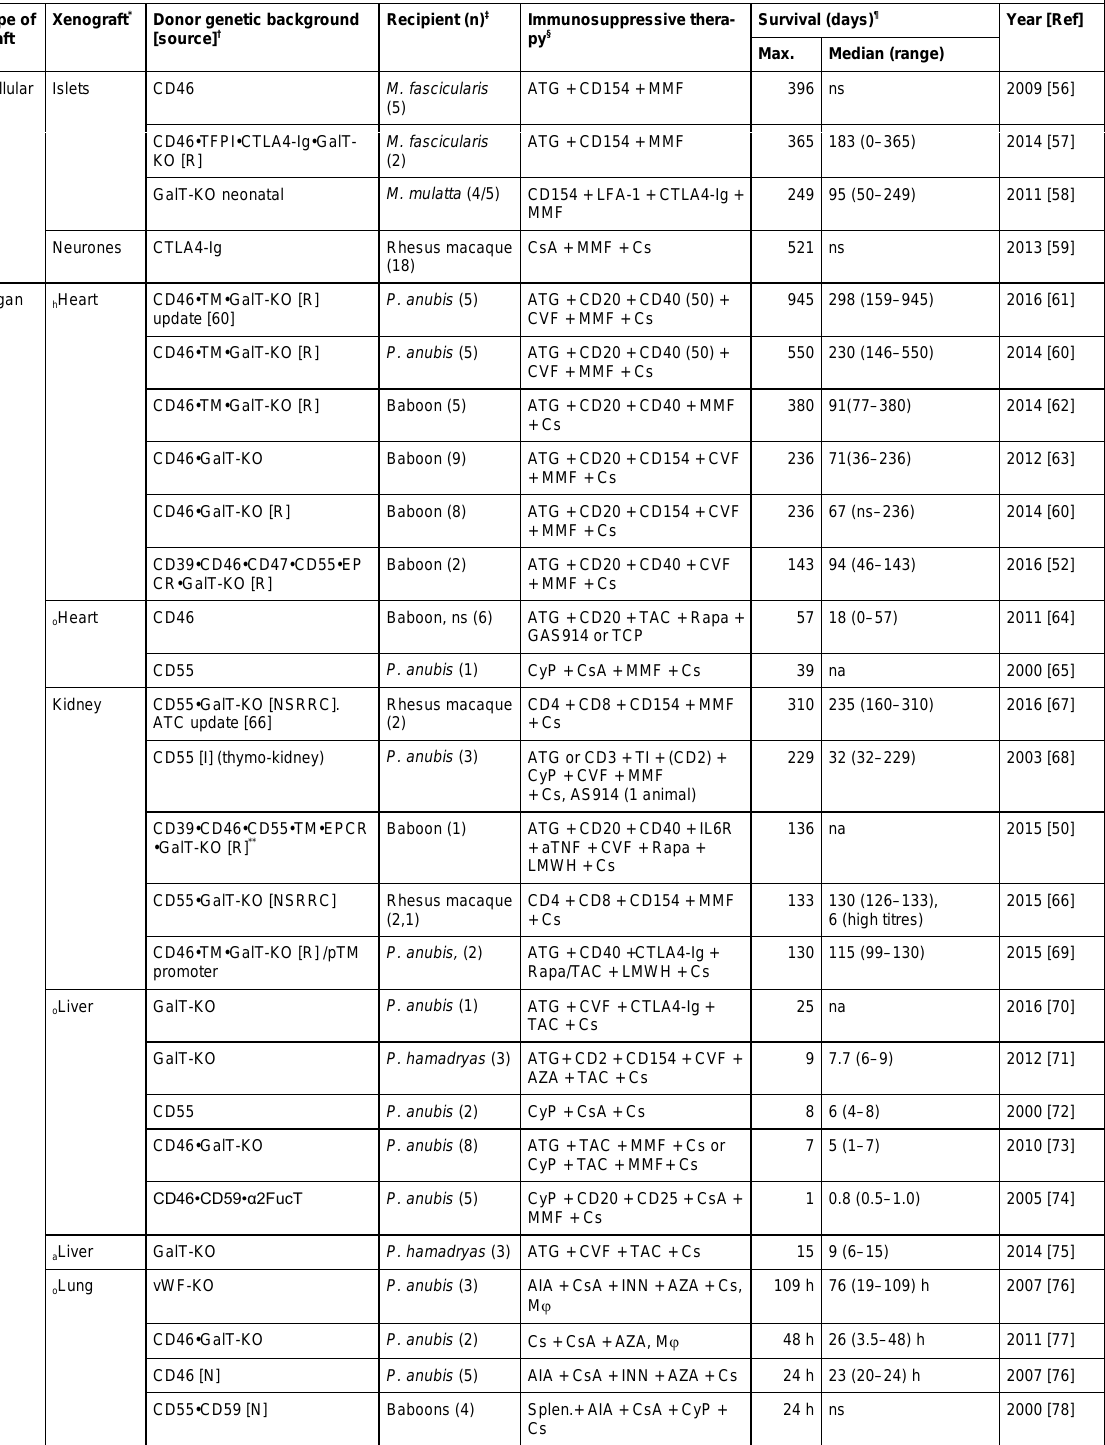
Table 2: Survival of xenografts from transgenic pigs into nonhuman primates (table adapted and expanded from [79]). Type of